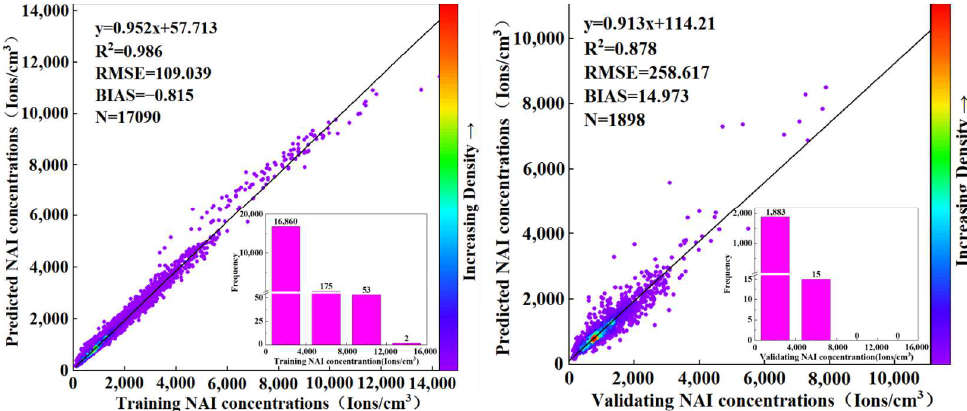
Figure 5. Model training results ( left ) and verification results ( right ) of the RF algorithm.